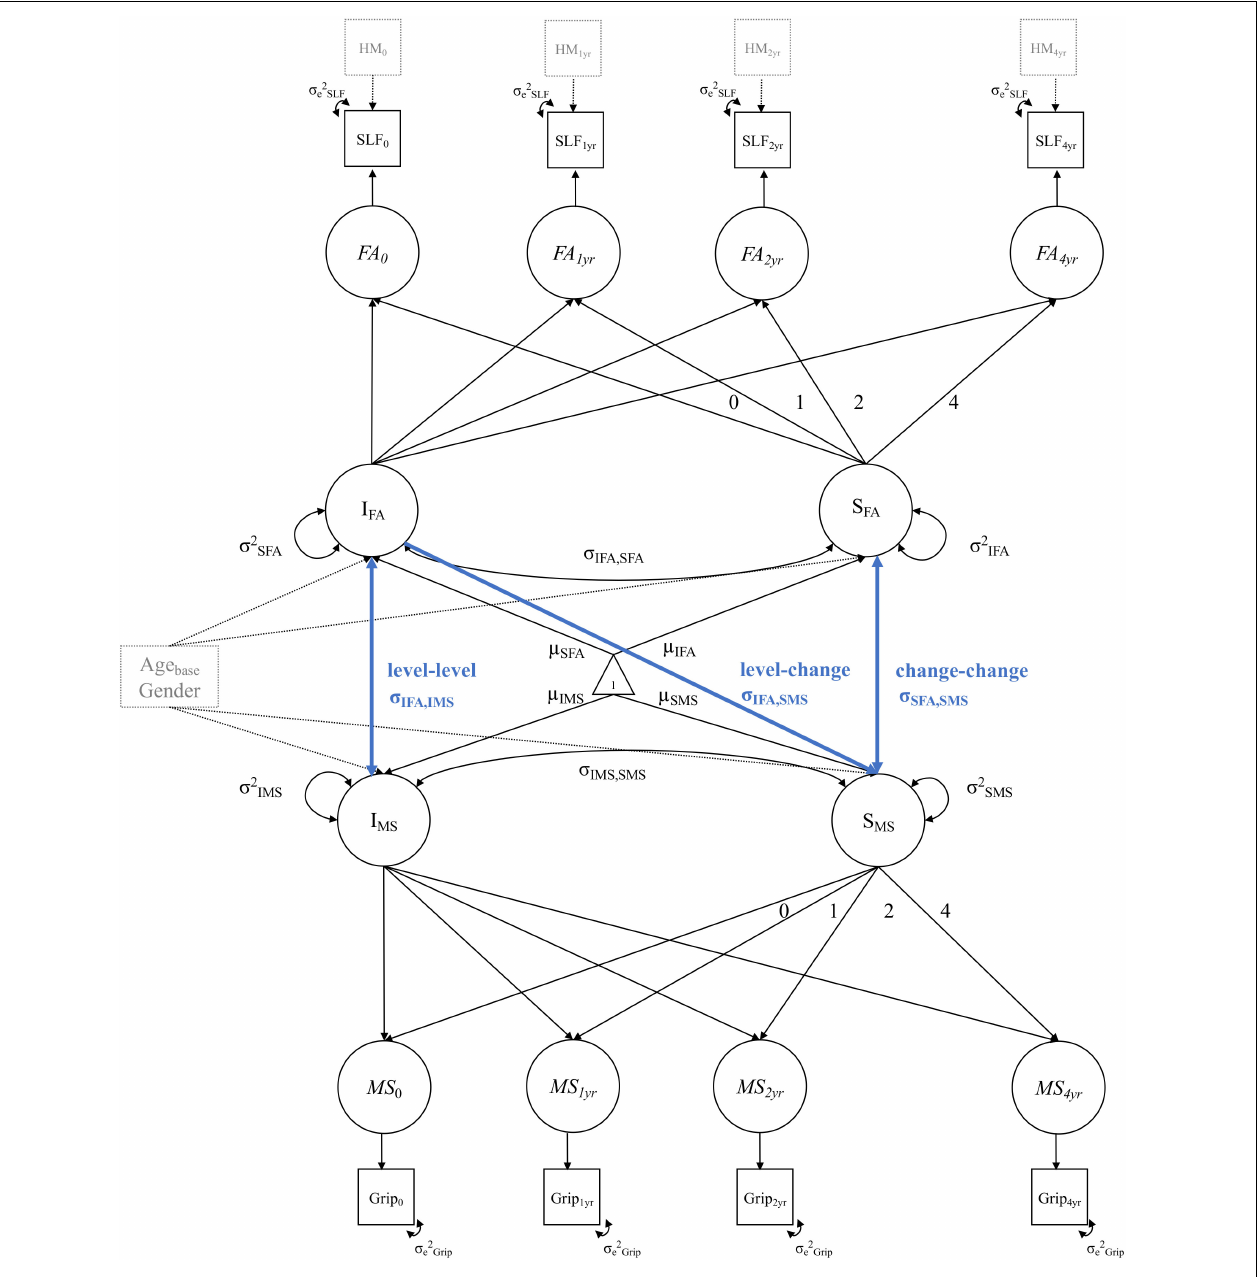
FIGURE 2 | Example diagram of a bivariate LGC model for motor strength (MS) in the grip force test (Grip) and WM FA in the SLF. Blue paths illustrate the cross-domain associations between (1) initial WM FA and motor performance at study baseline (level–level), (2) initial WM FA and subsequent change in motor performance (level-change), change in WM FA and change in motor performance (change–change). Single-headed arrows represent regression effects and double-headed arrows represent (co)variances and correlations. Circles represent latent, unobserved variables and squares represent manifest, observed variables. Triangles stand for constants, such as means and intercepts. All unlabeled paths are fixed to 1. Parameters with the same label are fixed to be equal. The manifest indicator intercepts are not shown for visual clarity. Intercept and slope variance for motor strength and WM FA is controlled for age at baseline (Age base ) and gender. The observed variables of WM FA in the SLF are controlled for head motion (HM) at each measurement occasion.